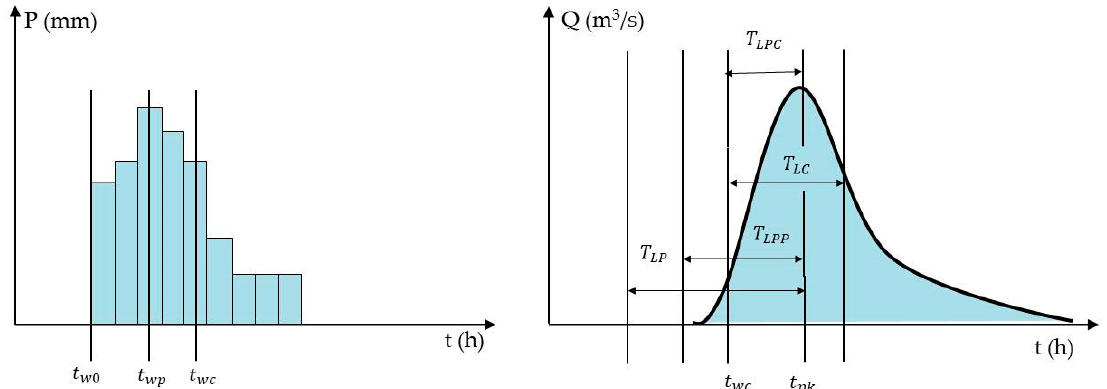
Figure 6. Definitions of terms used to describe hyetographs and response hydrographs. t w0 , beginning of precipitation; t wp , peak of precipitation; t wc , centroid of precipitation; t pk , time of peak discharge; t qc , centroid of runoff; T LPC , centroid lag-to-peak; T LC , centroid lag; T LP , lag-to-peak; T LPP , peak lag-to-peak. The other variables are the same as above.